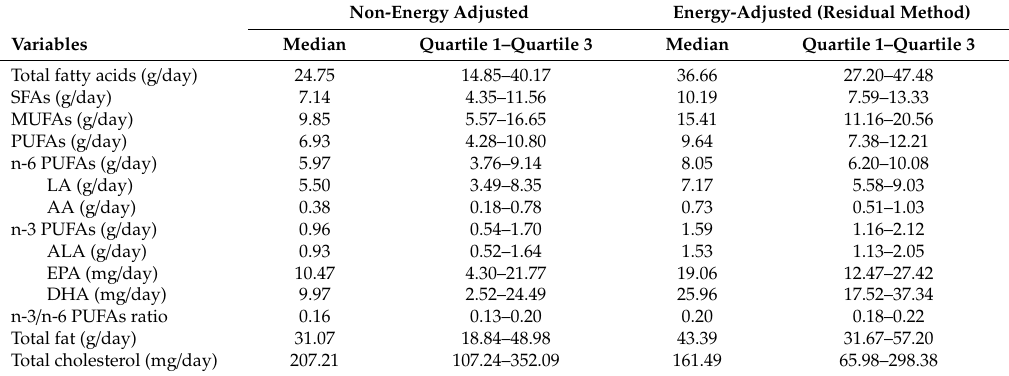
Table 2. The medians of dietary fatty acids and cholesterol intakes in controls with a normal range of total energy intake ( n = 6532).